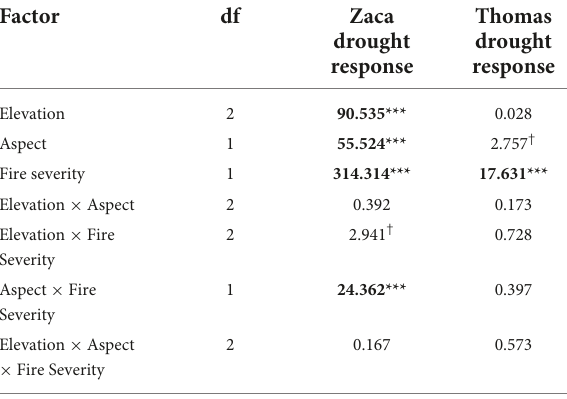
ValuesareF-statistics.Degreesoffreedomforeachfactorshowninthe“df”column.Bold values and asterisks indicate statistically significant p -values (*** P < 0.001; ** P < 0.01; * P < 0.05; † P <